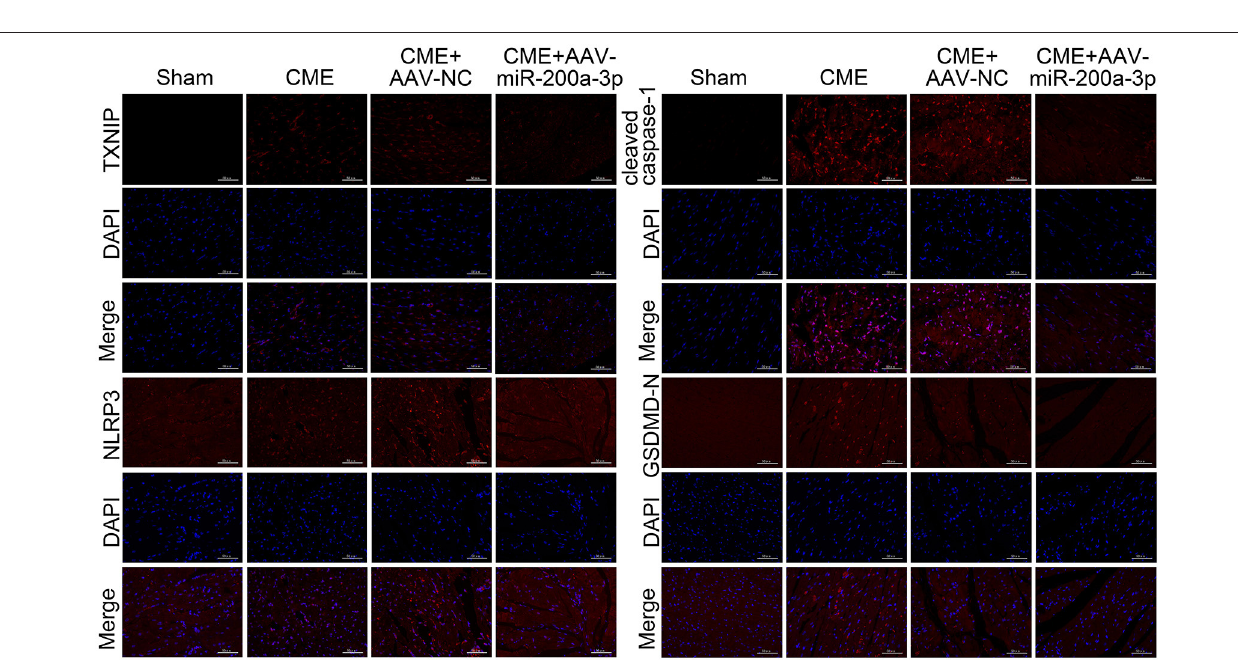
miR-200a-3p upregulation can decrease myocardial microinfarct size and inhibit cardiomyocyte death in CME model